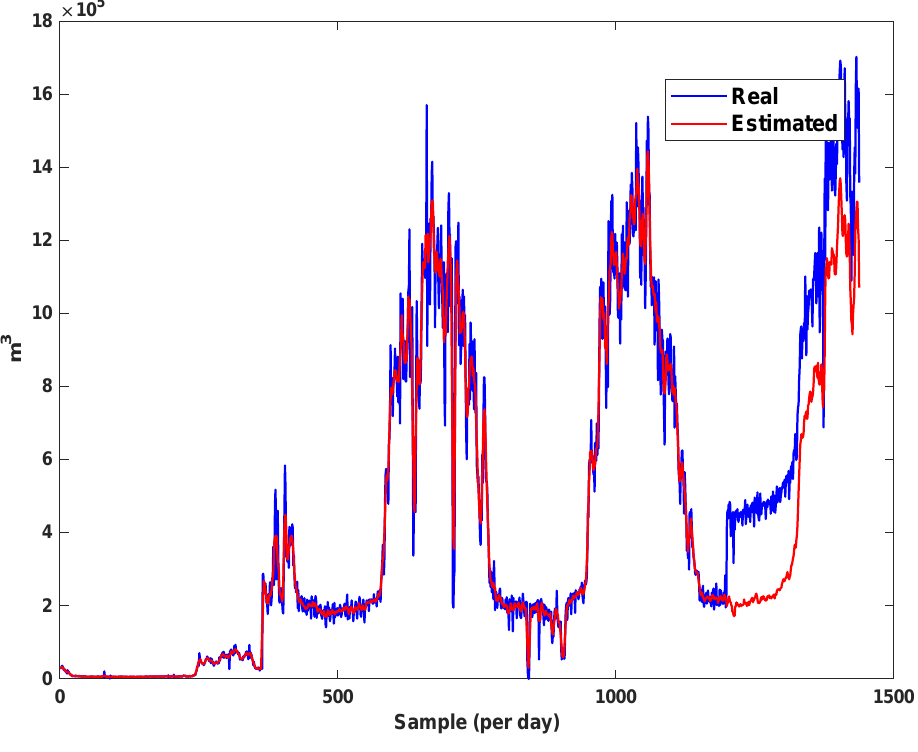
Figure 20. Detection fault 2: Total consumption.